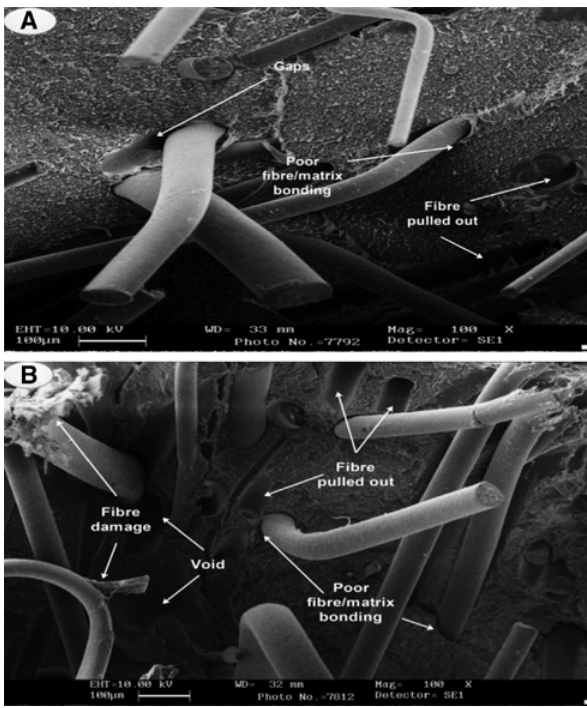
Figure 10: (A) SEM micrographs of untreated HF and (B) SEM micro- graphs of 0.25 N alkali-treated HF-reinforced composites.